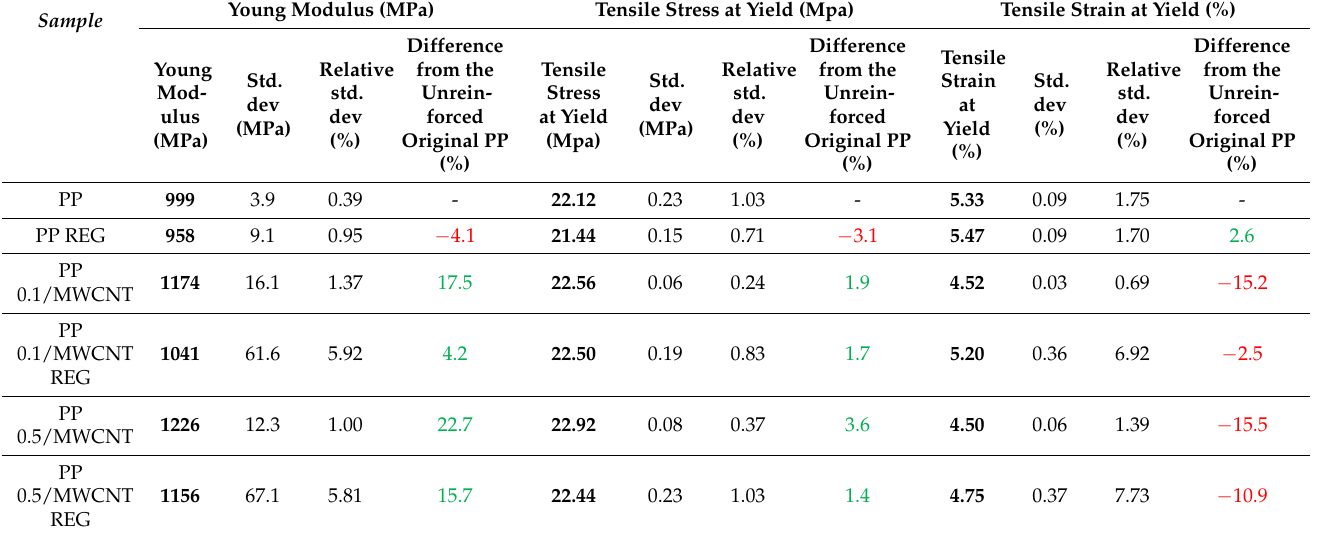
Table 1. Results of mechanical properties (tensile) of PP and PP/MWCNT nanocomposites (negative changes highlighted in red, positive changes in green).